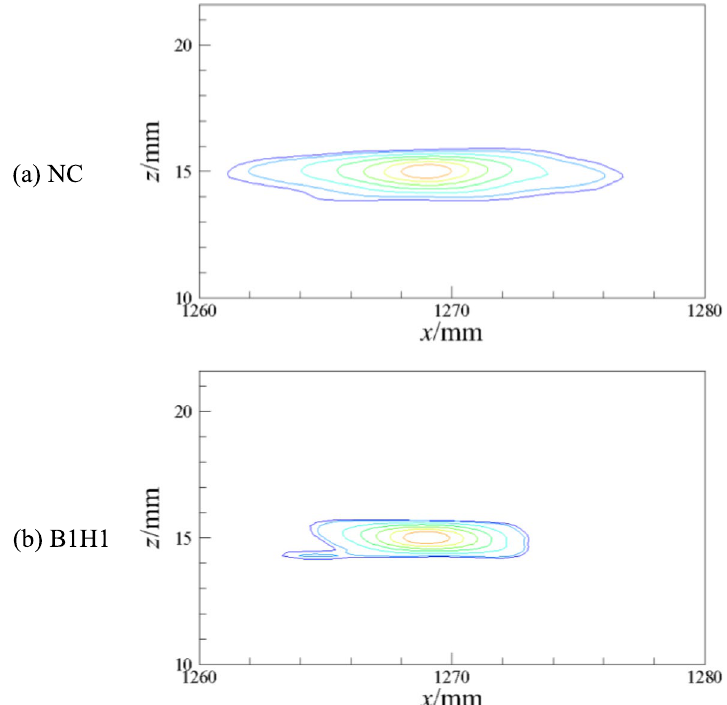
Fig. 17 Two-point correlation coefficient of streamwise fluctuating velocity in x - z plane at y +